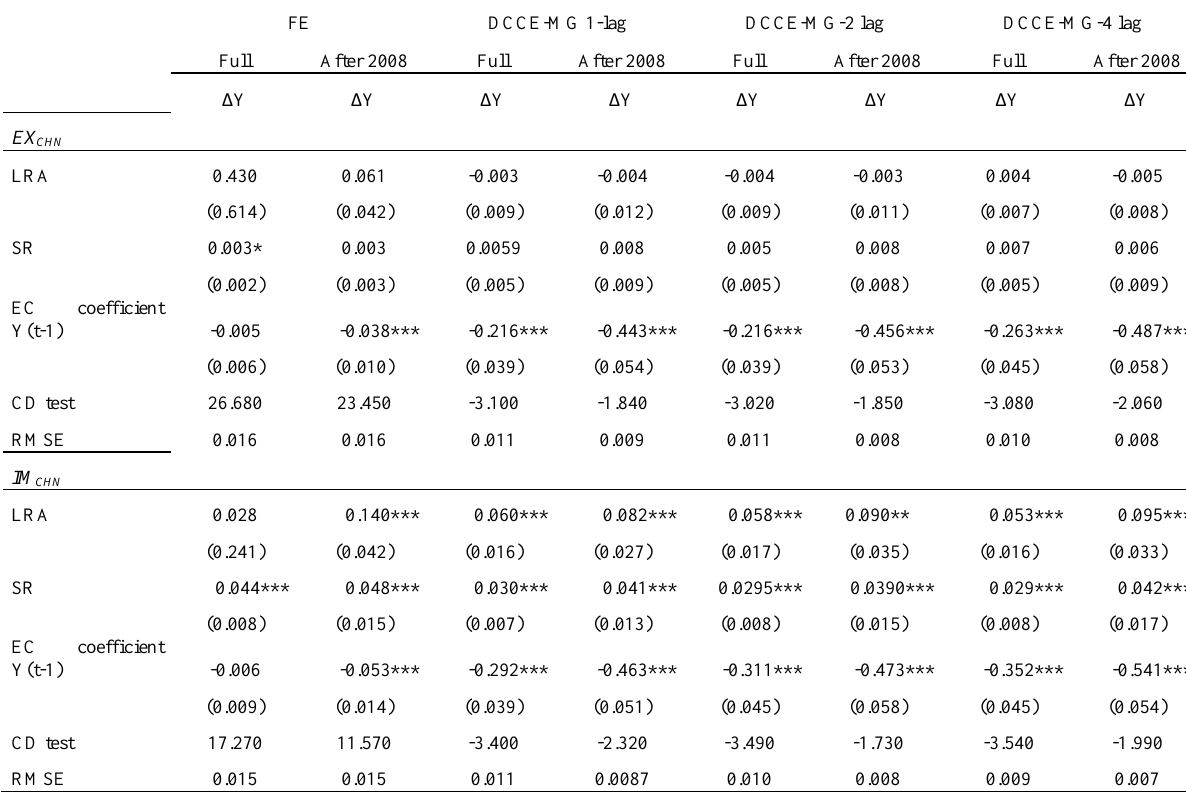
Table 7a : Dynamic models with the independent variables export and import to China